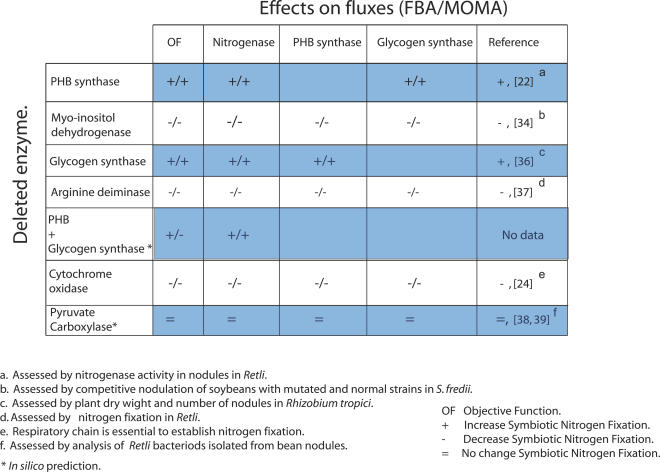
Experimental Validation with In Silico Gene DeletionsThe effects that mutations have on symbiotic nitrogen fixation was evaluated using linear (FBA) and quadratic (MOMA) programming [35]. This table shows the predicted increases (+) or decreases (−) in the OF, nitrogenase flux, PHB flux, and glycogen synthase flux with respect to the wild-type strain. Each entry of the table contains a pair of signs representing the effects of the deleted reaction on the fluxes. The first sign is the effect predicted by FBA, the second is that obtained from MOMA. At the end of each row we report the references that give experimental support to the increase or decrease of nitrogen fixation after the corresponding gene deletion. A brief description of the experimental assessment is presented in each gene deletion. In silico prediction of the effects of the double gene deletion (PHB and glycogen) depends on the optimization method (FBA or MOMA).